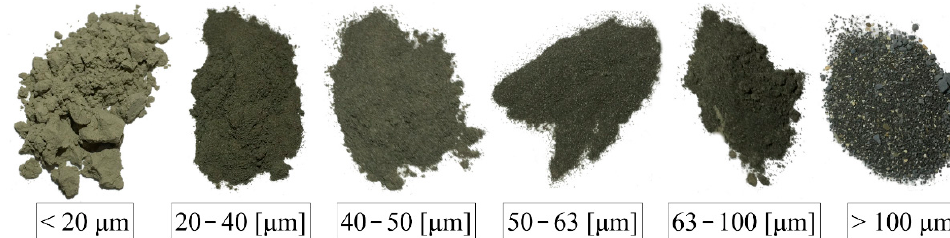
Figure 4. Particle size distribution of cement CEM I 42.5R, microsilica, and nanoparticles.